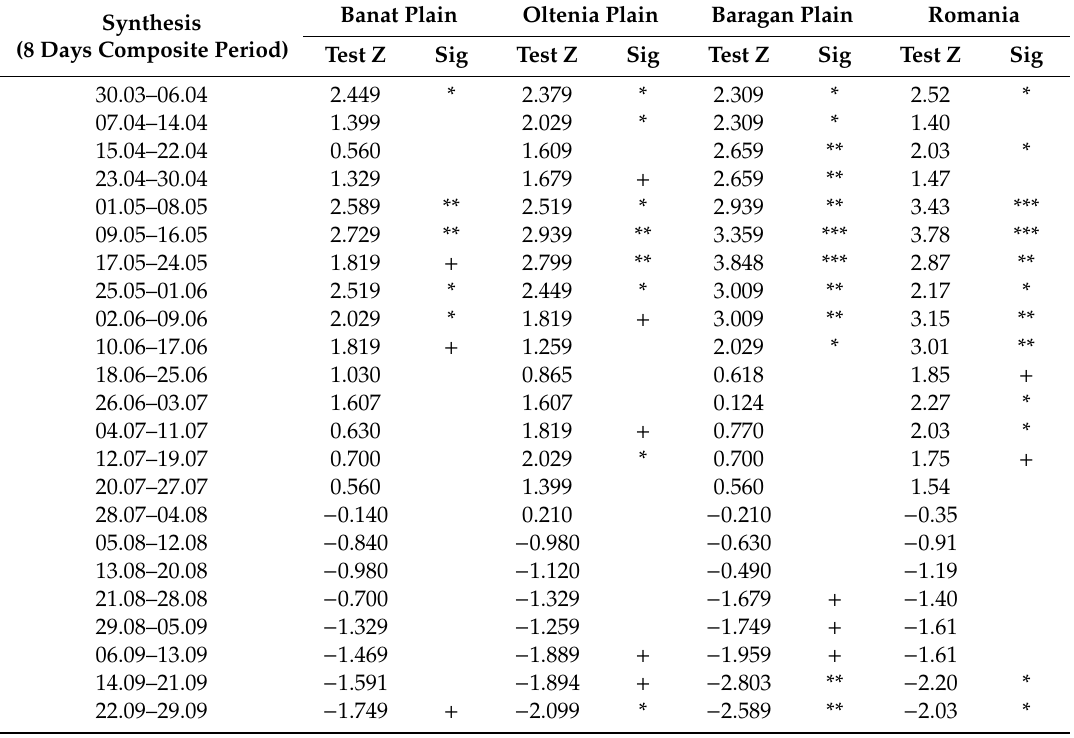
Table 4. Drought Severity Index trend according to the Mann-Kendall test (2001–2019).